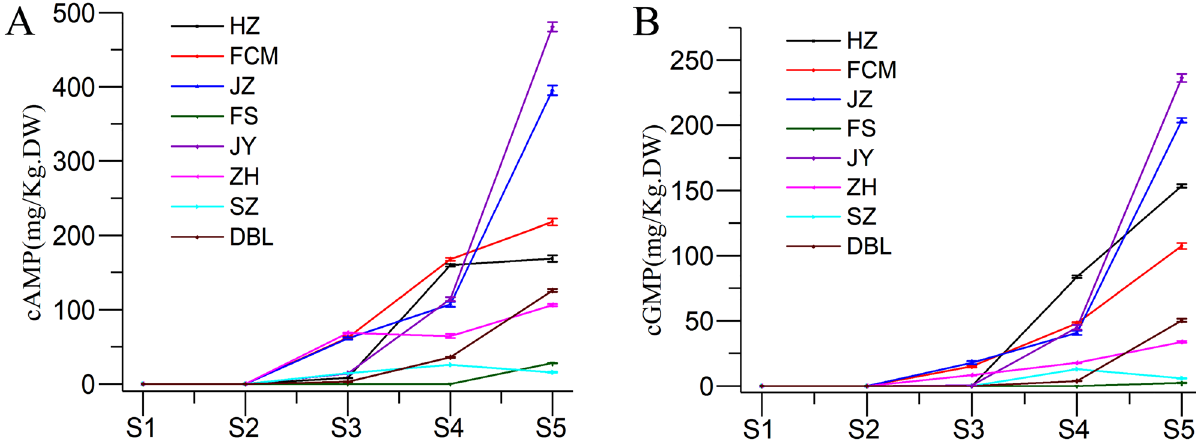
Figure 6. Changes in ( A ) cAMP and ( B ) cGMP of jujube fruit at various developmental stages.